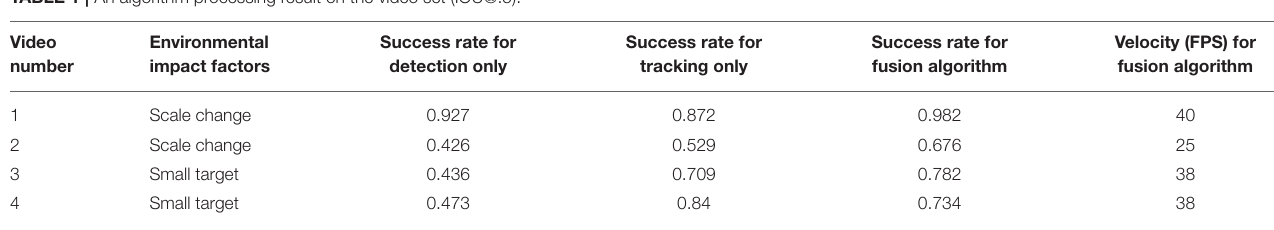
TABLE 1 | An algorithm processing result on the video set (IOU@.5). Video